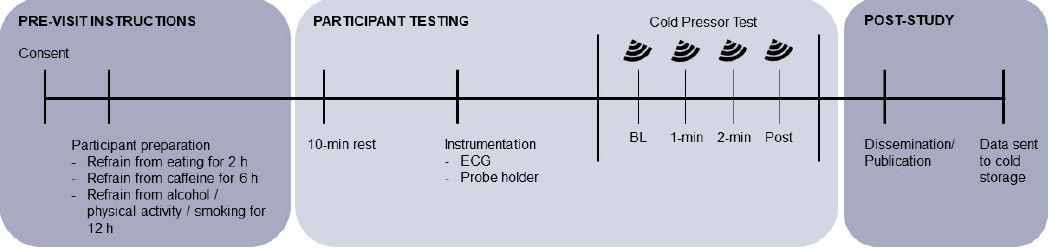
Figure 2. An example of a study timeline and protocol for the experiment outlined in the Research Example. ECG: electrocardiogram.